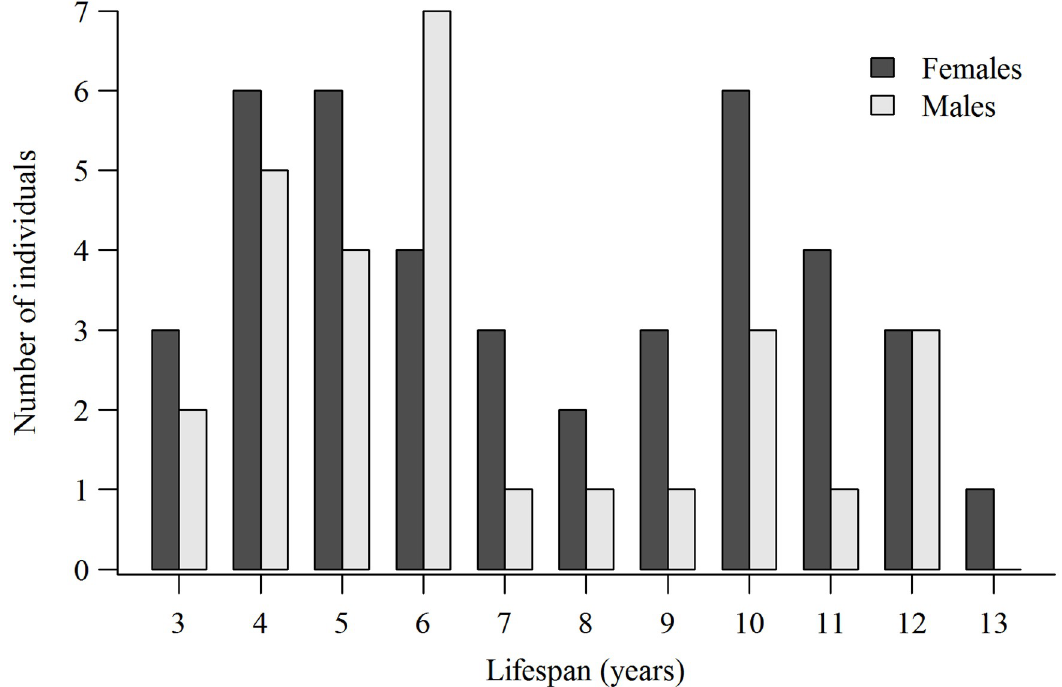
Fig 1. Number of goshawks by lifespan of known-age males and females. Lifespan of 28 male and 41 female northern goshawks of known-age (banded as nestlings or aged 2- or 3-years-old based on plumage at first breeding) northern goshawks first breeding in the 1992–2000 cohorts of breeders in Arizona, USA, 1991–2010.